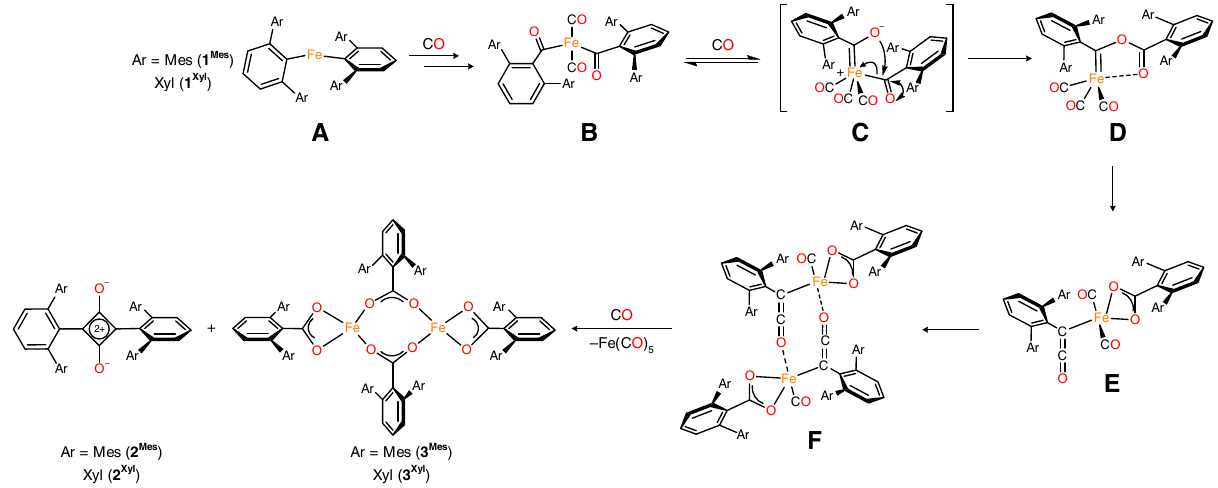
Fig. 4 Proposed pathway for the conversion of the iron(II) diaryls 1 Mes , 1 Xyl and 1 Naph to 2 – 4 . Proposed mechanism for the reaction between 1 Mes , 1 Xyl , and 1 Naph and CO forming squaraines 2 Mes and 2 Xyl , carboxylate complexes 3 Mes and 3 Xyl and carbene complex 4 . In the case of Ar =